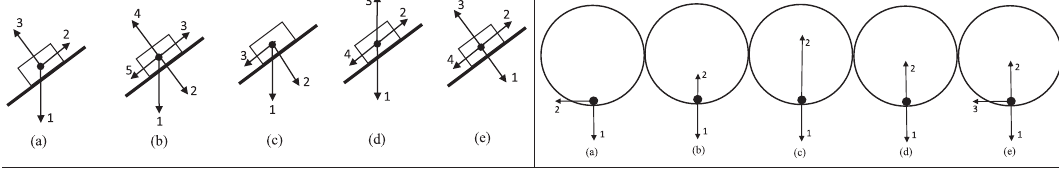
FIG. 4. Free body diagram